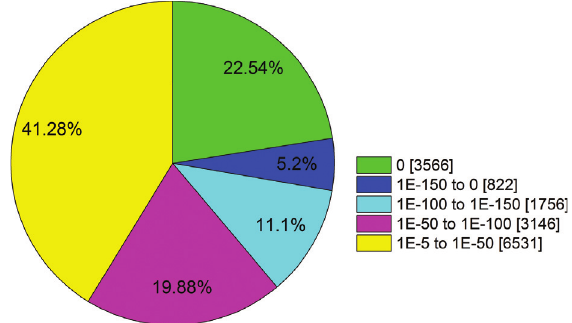
Figure 5 - E-value distribution of the top Blastx hits against the non- redundant (Nr) protein database for each unigene.